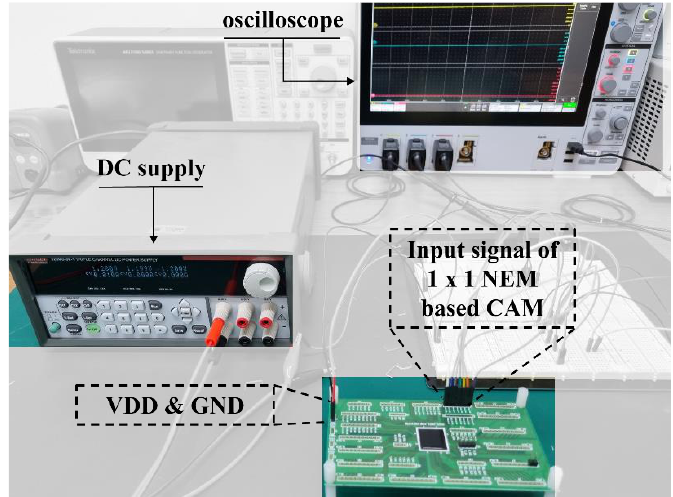
Figure 17. DC supply, oscilloscope, and chip-on-board (COB) setting for experiment.